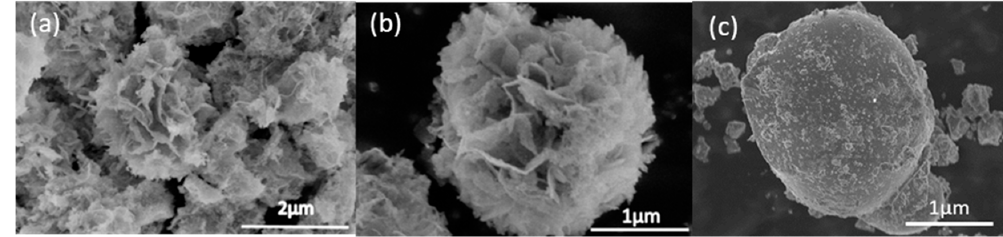
Figure 3. ( a – c ) Fourier-transform infrared spectroscopy images of flower-like BiVO 4 ; and ( c ) commercial BiVO 4 .